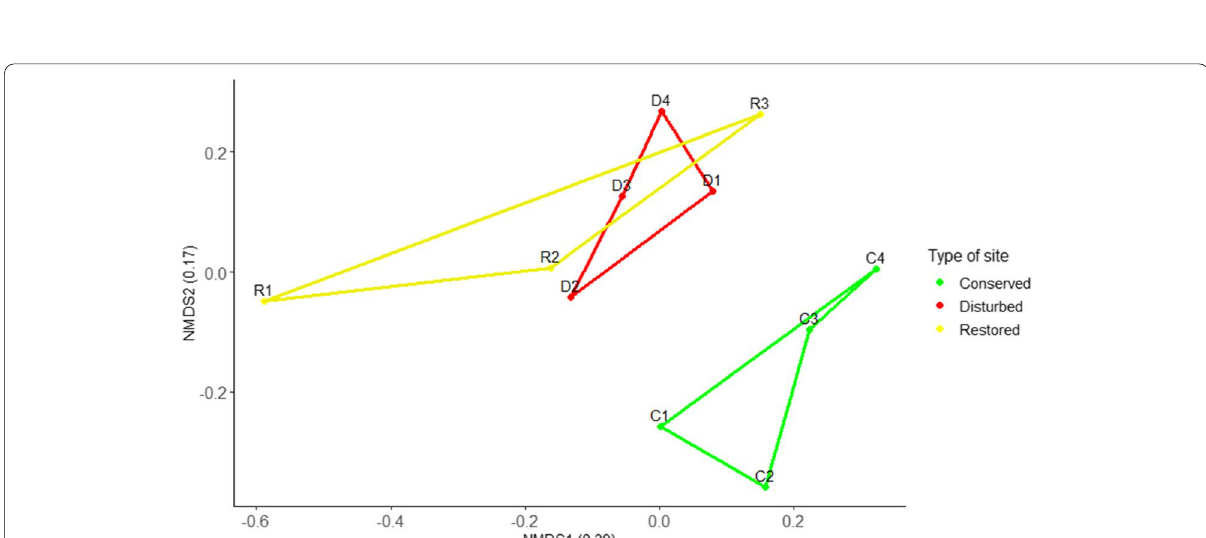
Fig. 5 Non‑metric Multidimensional Scaling showing the ordination of the 11 study sites in the PSAER, based on RTUs. Dots represent conserved sites; triangles represent disturbed sites and squares represent restored sites. The lines are the convex hulls of the polygons formed in each